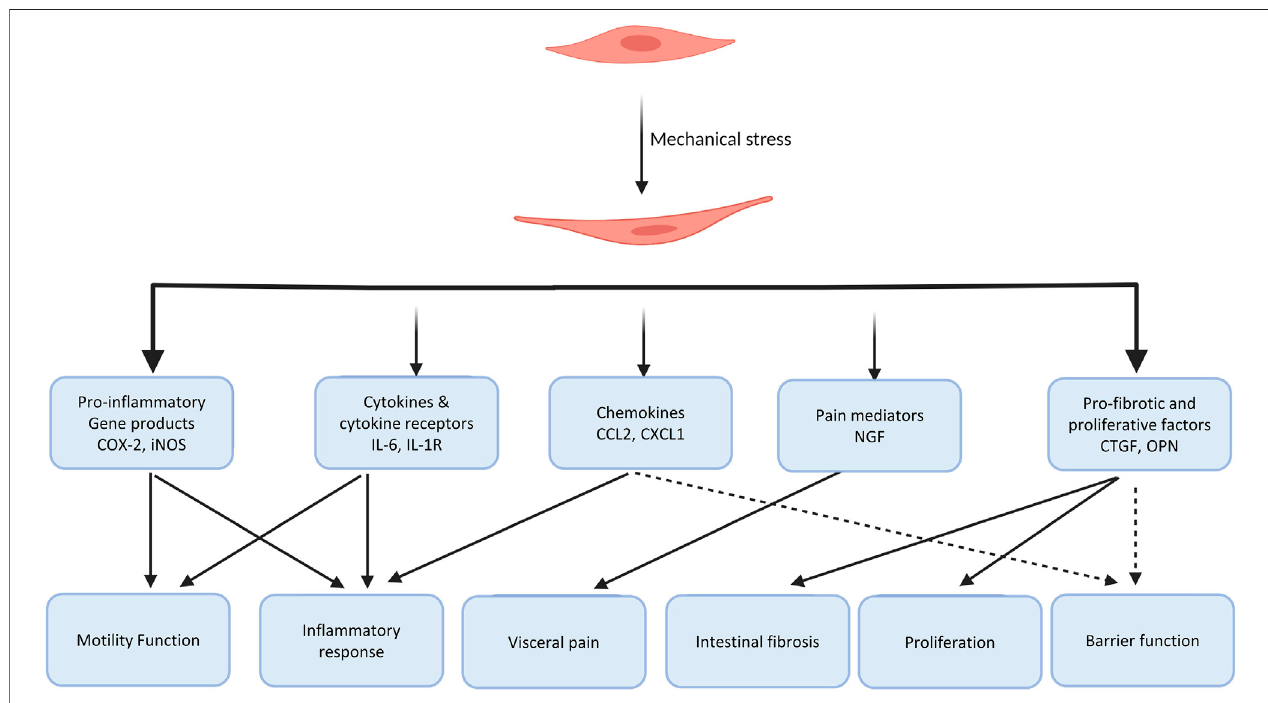
FIGURE5| Diagramsummarizingthegeneproductsandpathophysiologicalrolesofthemechano-transcriptionprocessinthegastrointestinaltract.Studiesupto date have shown that mechanical stress-induced gene expression of pro-in fl ammatory molecules, chemokines, cytokines and their receptors, pain mediators, pro- fi broticandgrowthfactorsplayacriticalroleinpathogenesisofmotilitydysfunction,in fl ammatoryresponse,visceralpain,intestinal fi brosisandcellproliferationinthegut. It is yet to determine if the mechano-transcription process is involved in secretion, permeability, and other functions and dysfunctions in the gut.